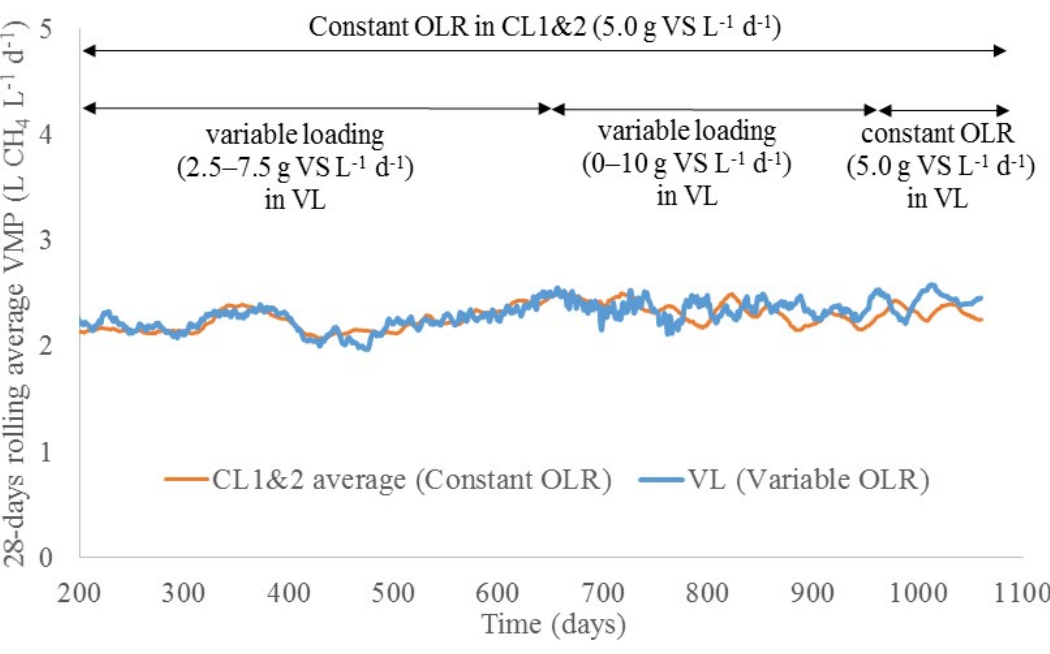
Figure 3. Operational parameters of digester VL with variable OLR and the control with constant loading (CL1&2, average values): ( a ) pH of digester content (measured in digestate leaving the digester); ( b ) Ammonia of digester content (additionally, TKN of feedstock is provided); ( c ) Alkalinity of digester content.